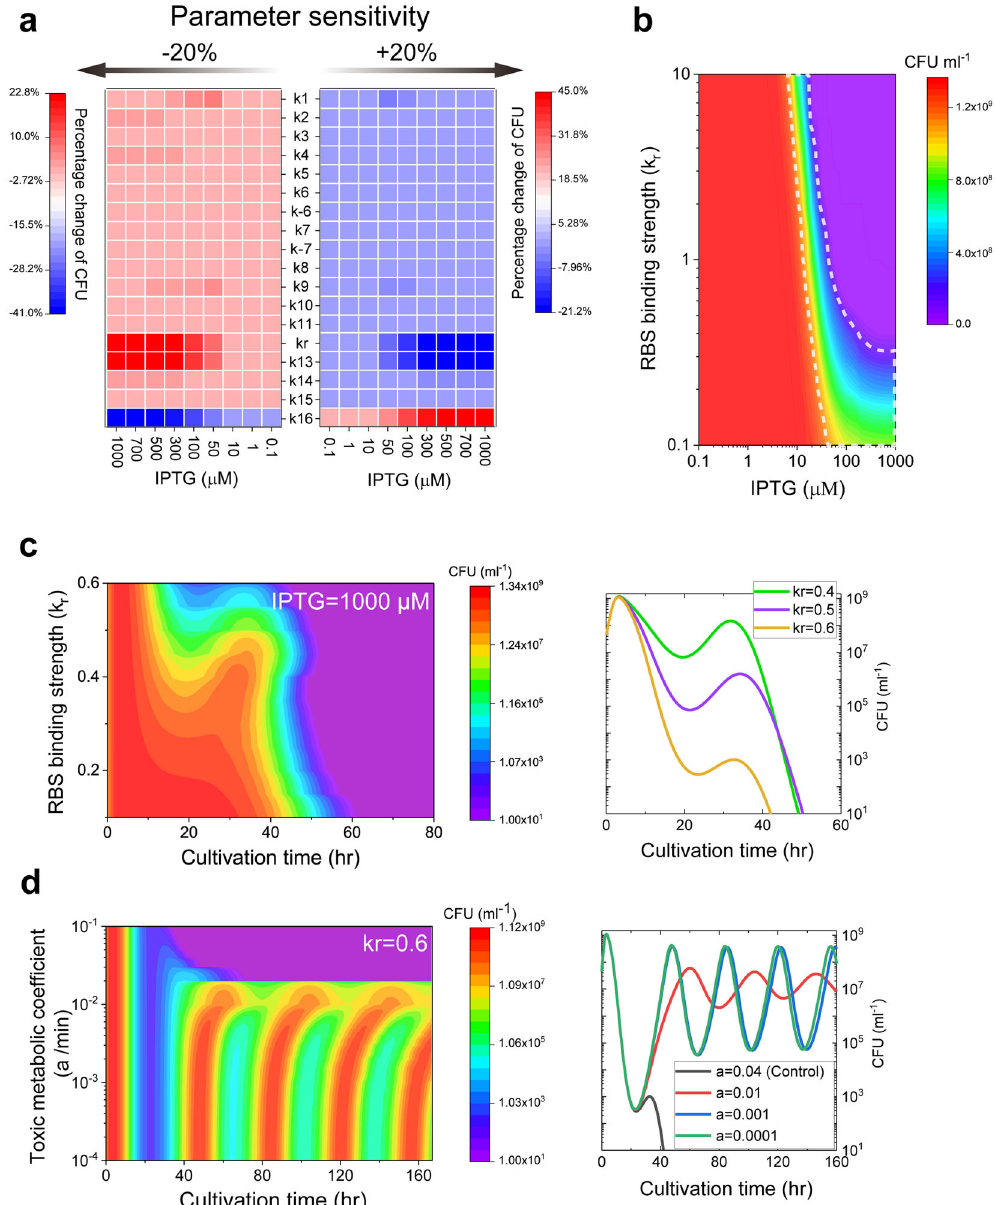
Fig. 5 RBS-binding ef fi ciency and toxic metabolic by-products in controlling bacteria population density. a Sensitivity analysis of the parameters in mediating population density. Parameters are varied ±20% from their de fi ned values reported in Supplementary Table 1. The corresponding percentage change of the population density is calculated. b Change of population density under different RBS-binding strengths ( k r ) with a series of IPTG induction doses during the stationary phase. c Change of bacteria-growth curve under different RBS- binding strengths ( k r ) with 1000 μ M IPTG induction. The growth curves corresponding to the three typical RBS-binding strengths (0.4, 0.5, and 0.6) are shown in the right panel. d Change of bacteria-growth curve under different toxic metabolic coef fi cients ( a ) at the RBS-binding strength of 0.6 with 1000 μ M IPTG induction. The growth curves corresponding to the three typical coef fi cients (0.01, 0.001, and 0.0001) are shown in the right